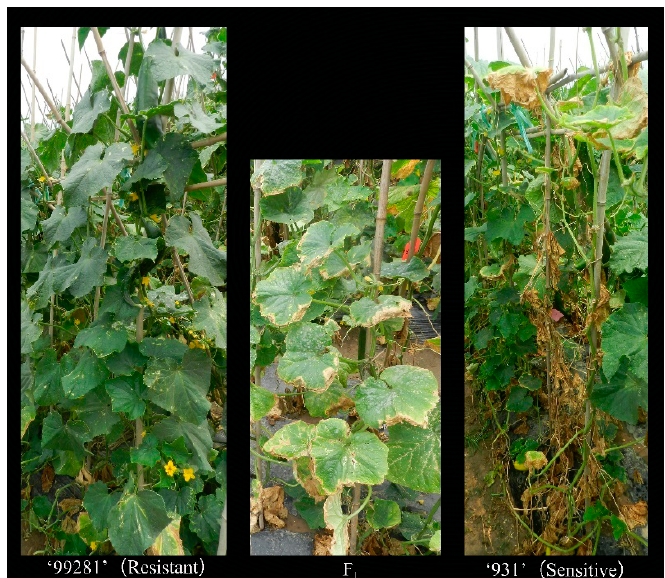
Figure 2. Phenotypes of parents and F 1 under heat stress. Parental line “99281” is heat-tolerant with no obvious damage on the leaves, and “931” is heat-sensitive with leaves wilting and the whole plant died. F 1 showed moderate heat tolerance.